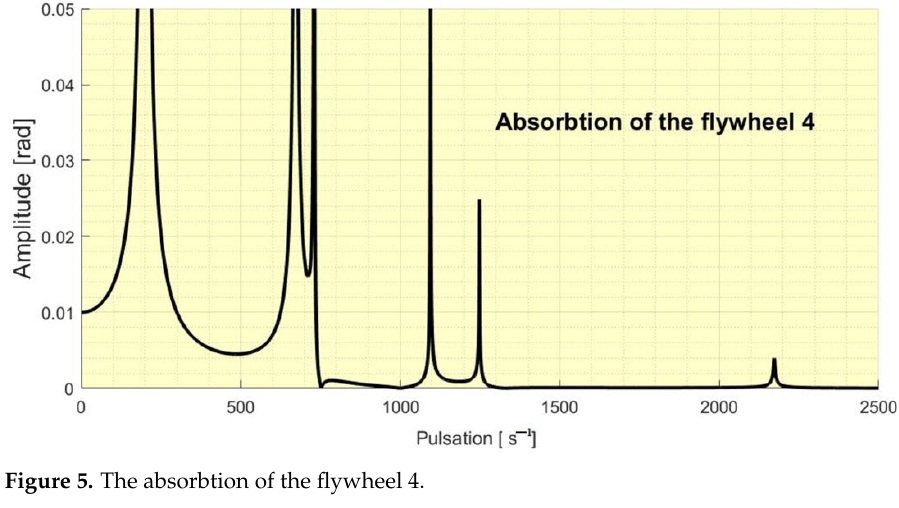
Figure 5. The absorbtion of the flywheel 4.